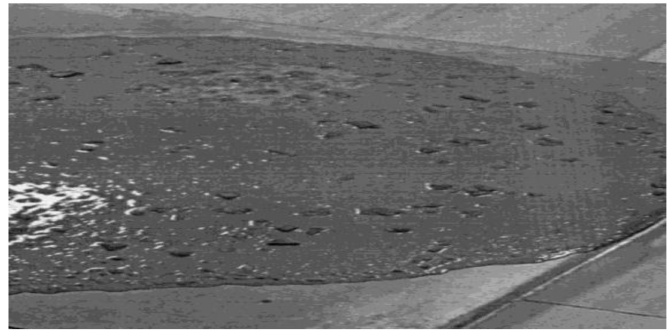
Figure 5. Self-compacting concrete mix with 88 cm cone